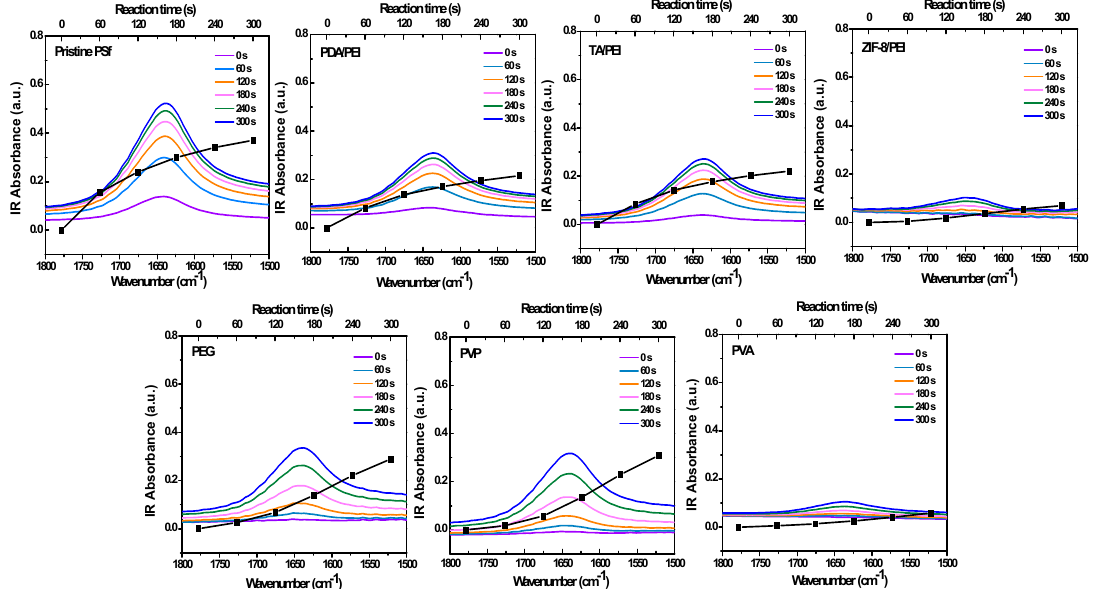
Figure 2. The in situ FT-IR spectra and absorbance intensities growth of polyamide formation process on porous substrate, which were characterized by the C=O stretching vibration at 1640 cm − 1 .